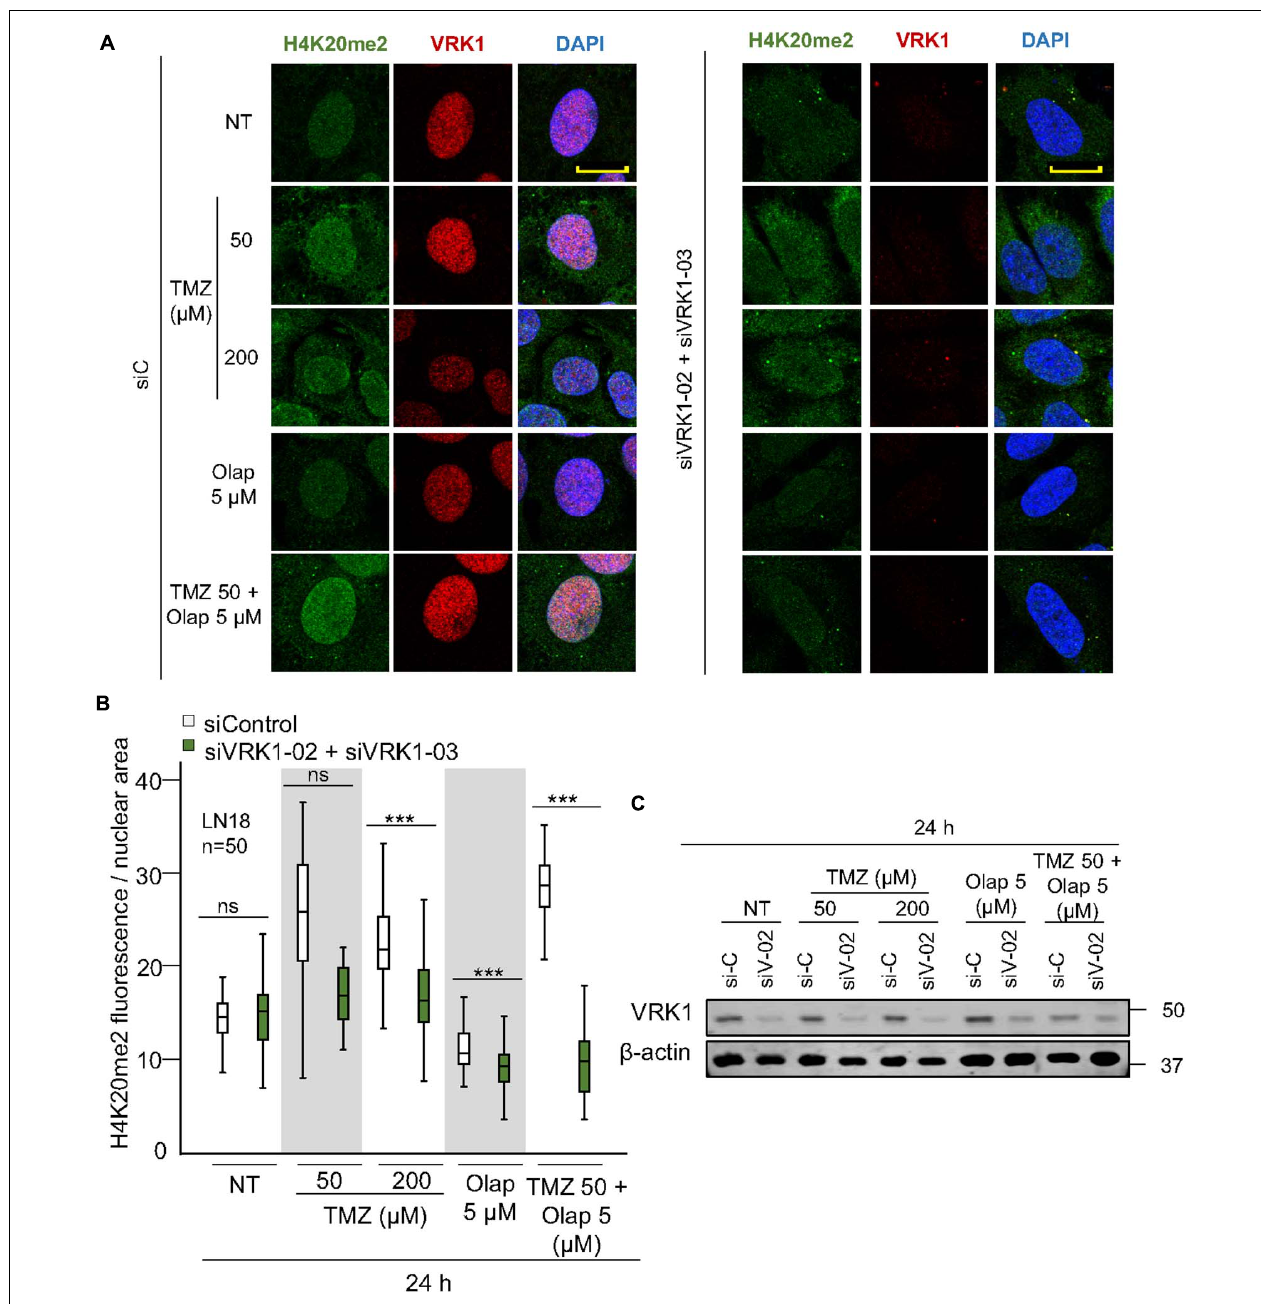
FIGURE 4 | VRK1 knockdown impairs H4K20me2 after TMZ and olaparib treatments. (A) Left. Effect of siControl on H4K20me2 induced by TMZ, olaparib and their combination. Right. Effect of the combination of siVRK1-02 and siVRK1-03 on H4K20me2 induced by TMZ, olaparib and their combination. (B) Quantification of the effect of VRK1 depletion on H4K20me2 fluorescence per nuclear area. Fifty cells per condition in triplicate were quantified. Field images shown in Supplementary Figure 7 . NT: no treatement. Scale bar = 10 µ m. *** p < 0.001. (C) Western blot showing the effect of VRK1. β -actin was used as load